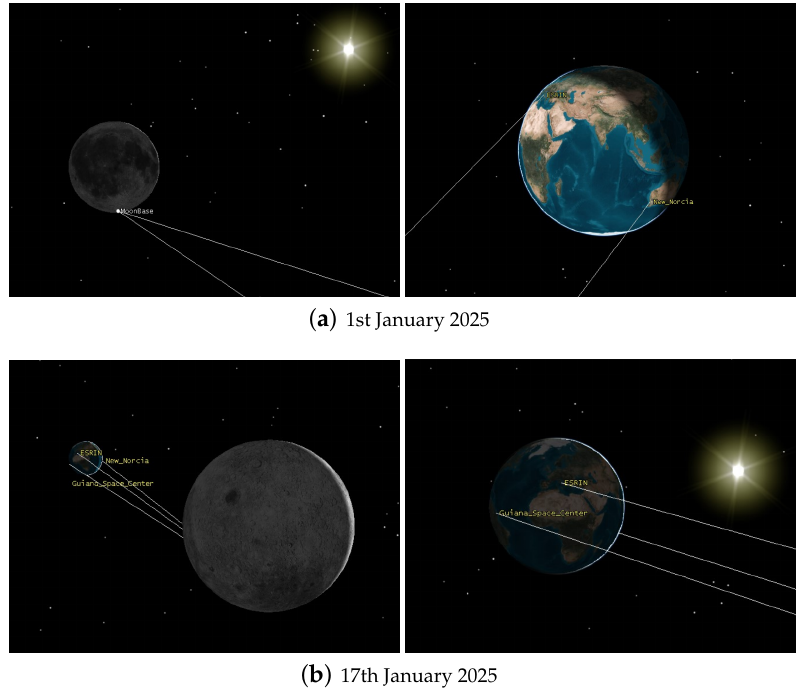
Figure 2. Distances and angles. Moon centered and Earth centered visuals in two different days; ( a ) 1 January 2025 and ( b ) 17 January 2025. In the first case, two ground stations (ESRIN and New Norcia) are visible from the Moon; in the second case, the visibility is extended to three ground stations (ESRIN, New Norcia and Guiana Space Center). The simulations have been carried out with